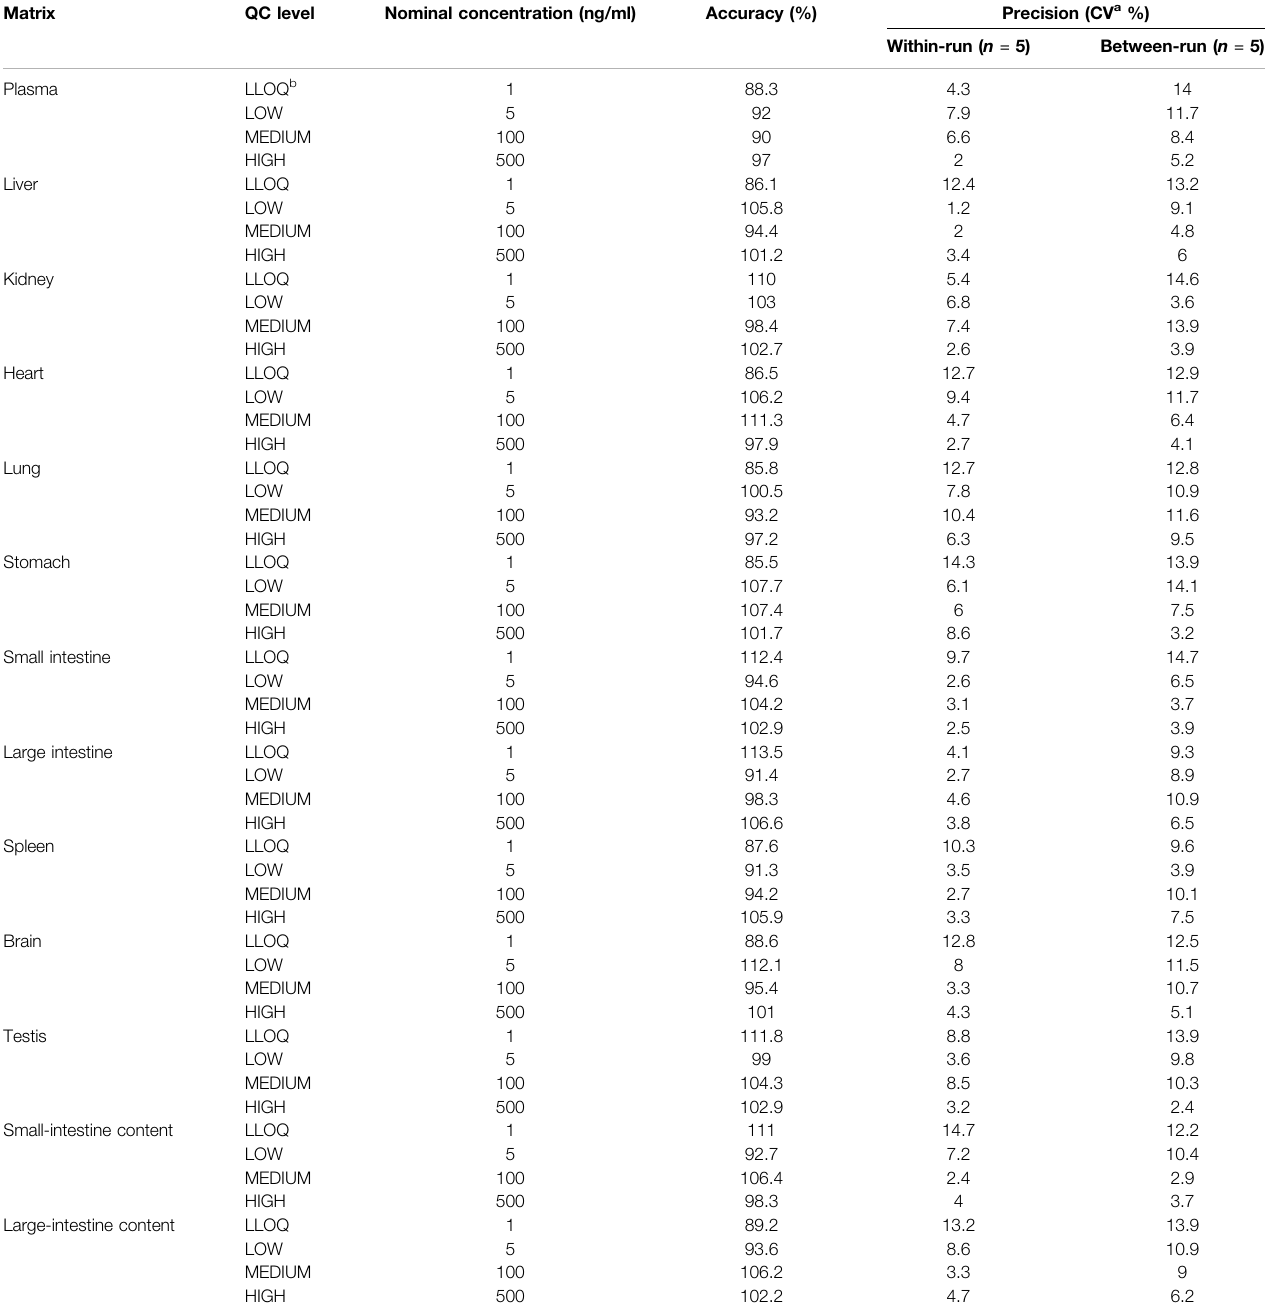
TABLE 2 | Accuracy, within-run and between-run precision for Indo5 in rat plasma and tissues. Matrix QC level Nominal concentration (ng/ml) Accuracy (%) Precision (CV a %)